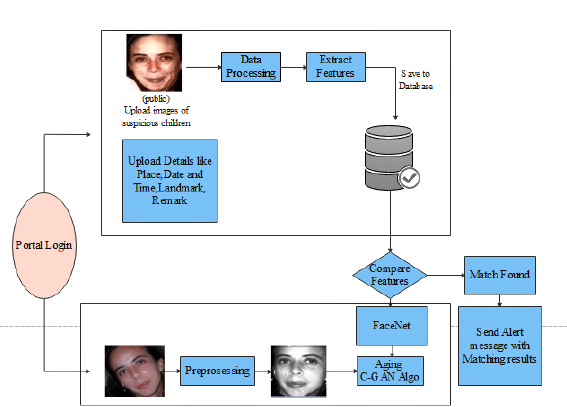
Figure 4. System design for lost child idetification using FaceNet and C-GAN.